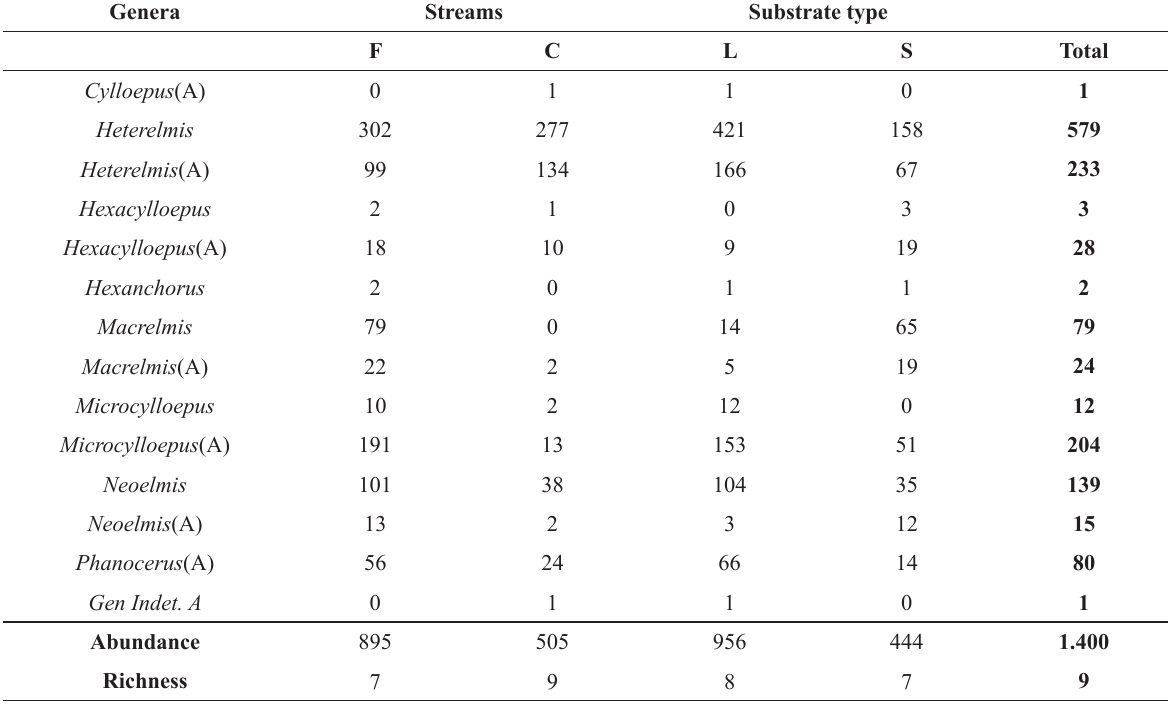
Composition, richness and abundance of riffle beetle genera sampled in forested (F) and deforested (C) streams and substrate types (L = leaf litter; S = stone). Letter ‘(A)’ at the end of genus name indicates adult life